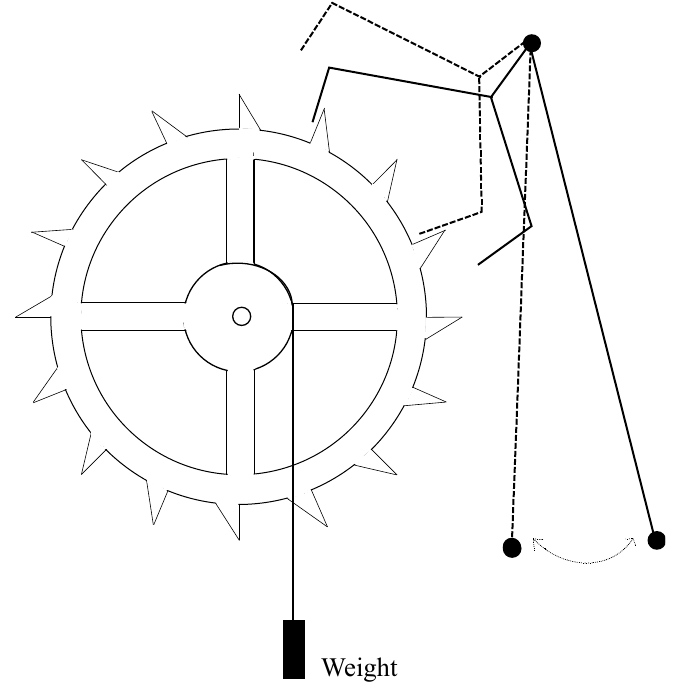
Figure 1. Simplified diagram of an escapement mechanism.